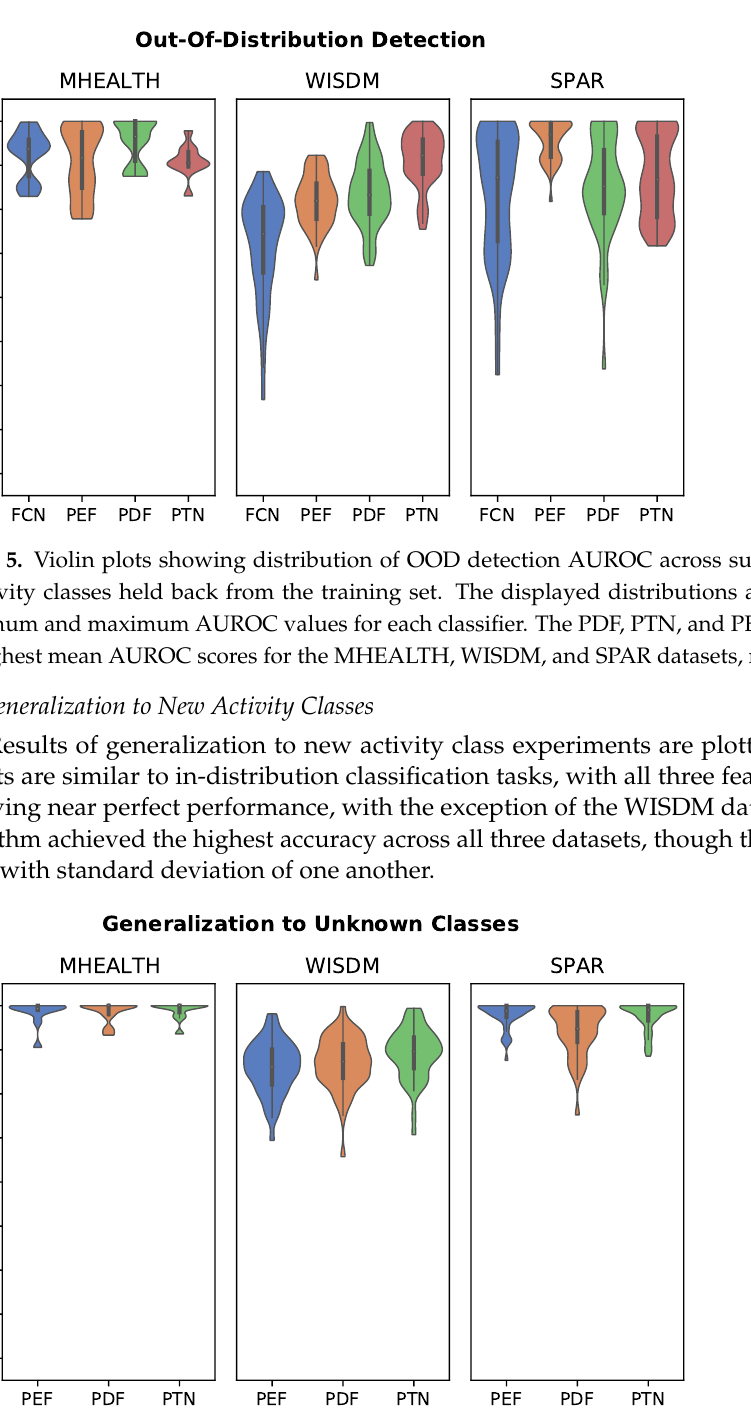
Figure 6. Distribution of activity classification performance when generalizing an embedding to novel activity classes, with 30% of activity classes held back from the training set. The PTN model achieved the highest mean accuracy across all three